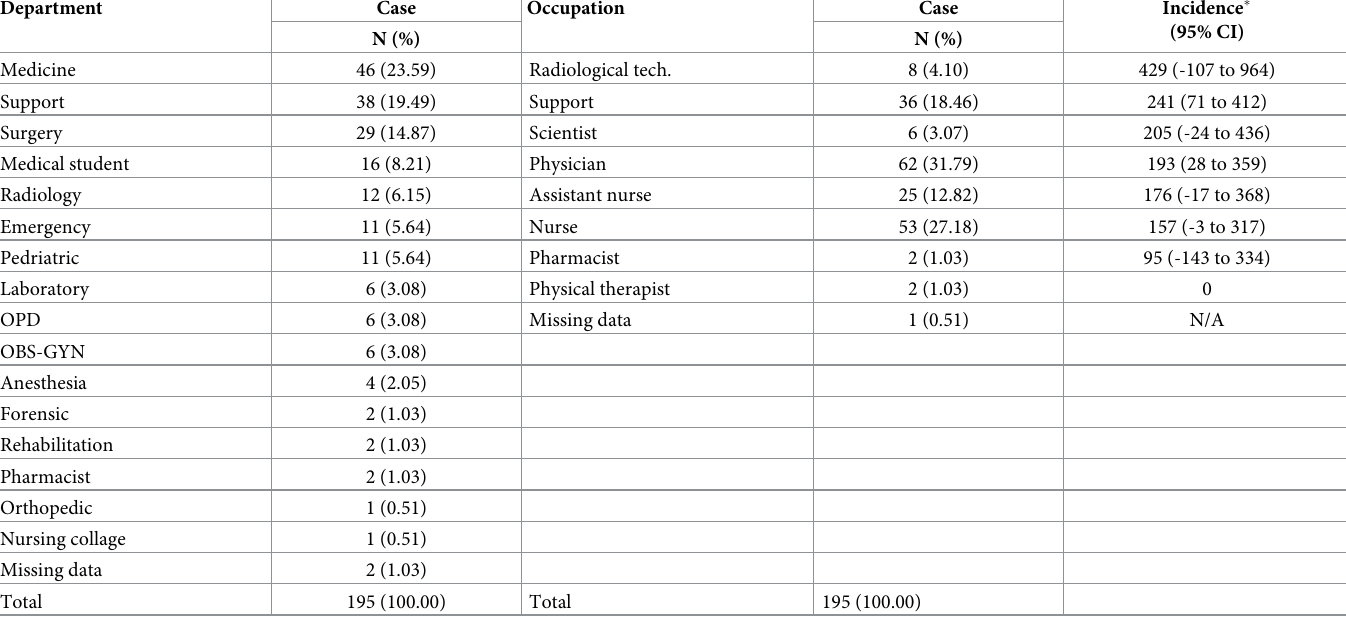
Table 3. Department of work and profession of HCWs with TB disease at KCMH from 2003–2020.